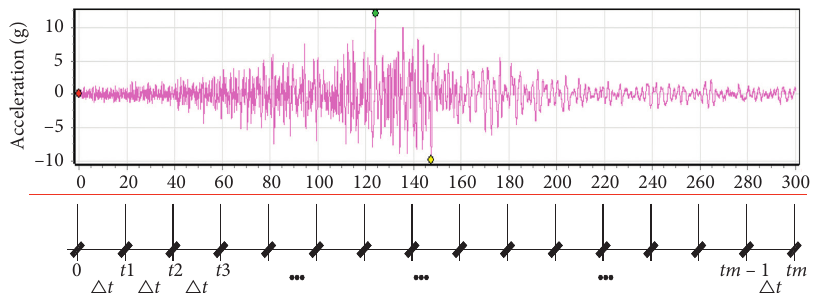
Figure 5: Seismic wave splitting indication.